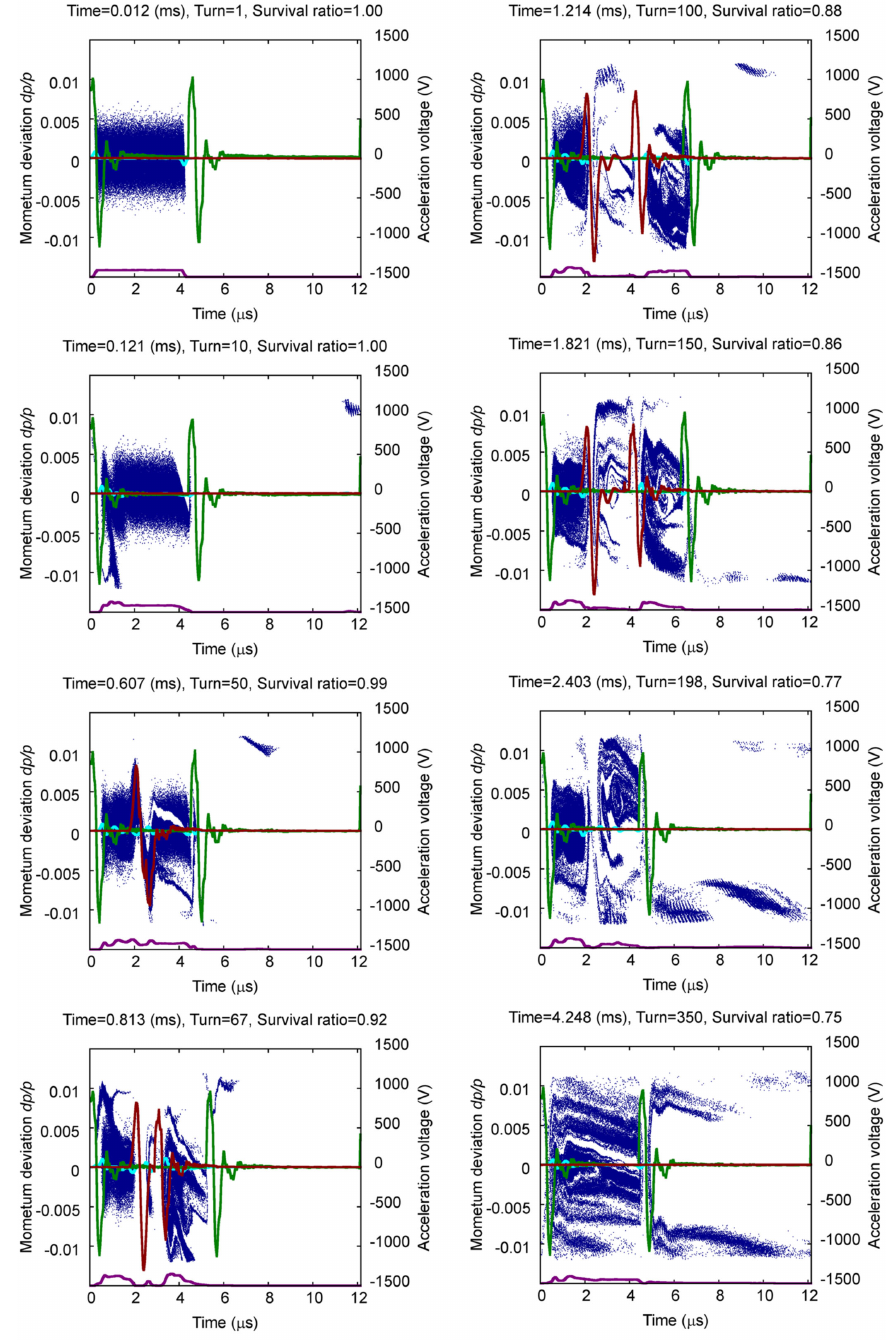
FIG. 8. Snapshots of the beam distribution in the longitudinal phase space in the onDBB at the 1st, 10th, 50th, 67th, 100th, 150th, 198th, and 350th turns, from the top left to the bottom right. The red-colored line indicates the superimposed waveform of the two intermediate voltages. Other colored lines are the same as those in Fig.